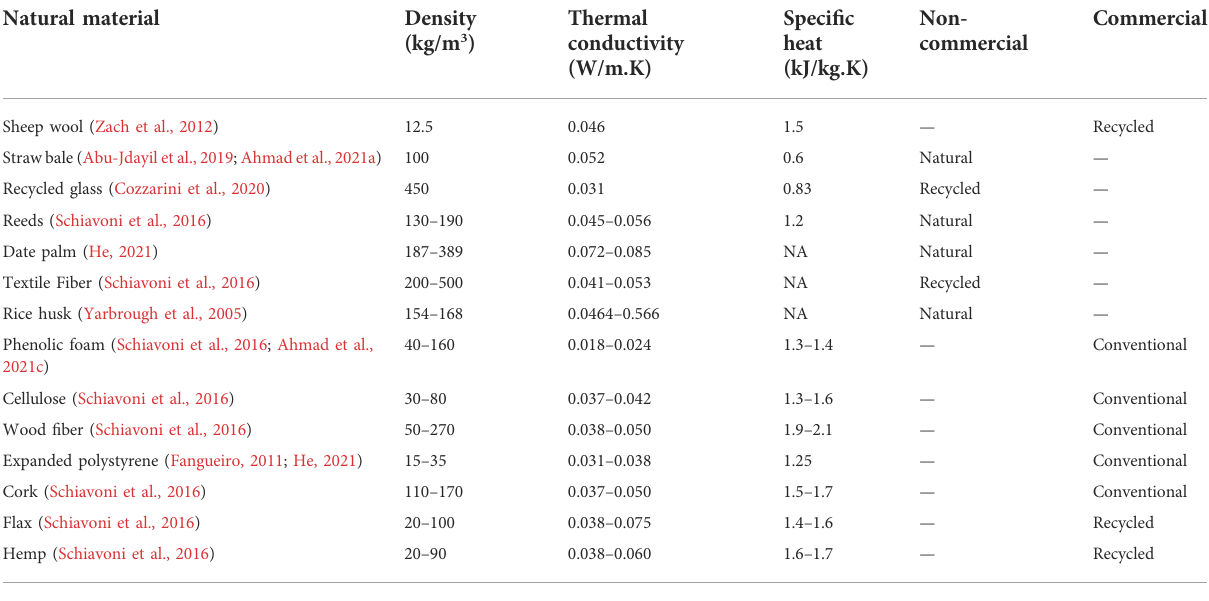
TABLE 1 Commercial and non-commercial insulation materials.